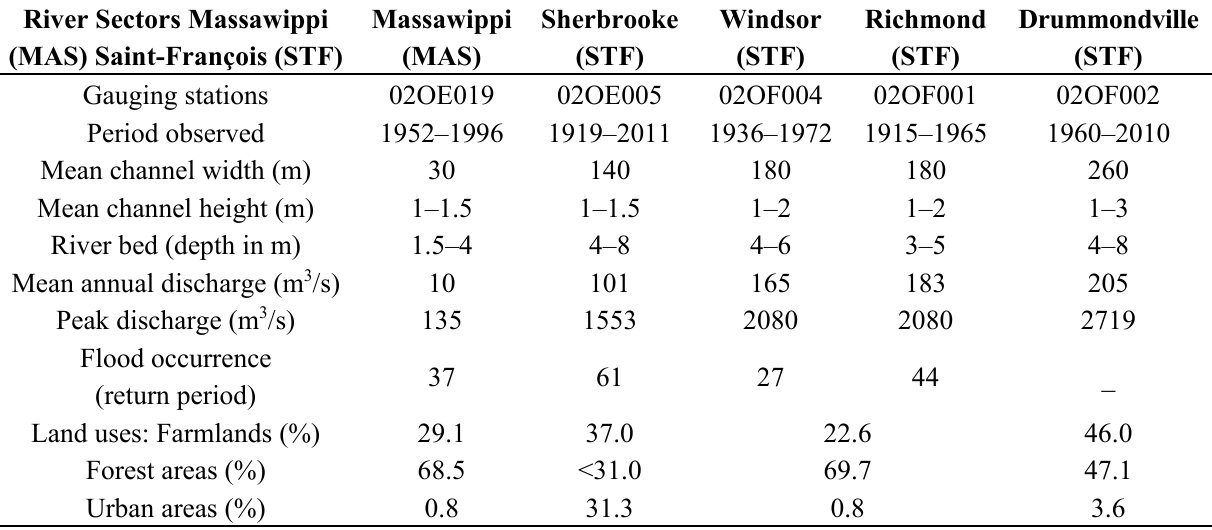
Figure 1. Location of sampling sites along the Massawippi (MAS) and Saint-François rivers (STF), in southern Québec, Canada. The watershed of Massawippi River appears in gray color on the map. Table 1. Hydrological data from gauging stations located in the François River Basin (Southern Québec,